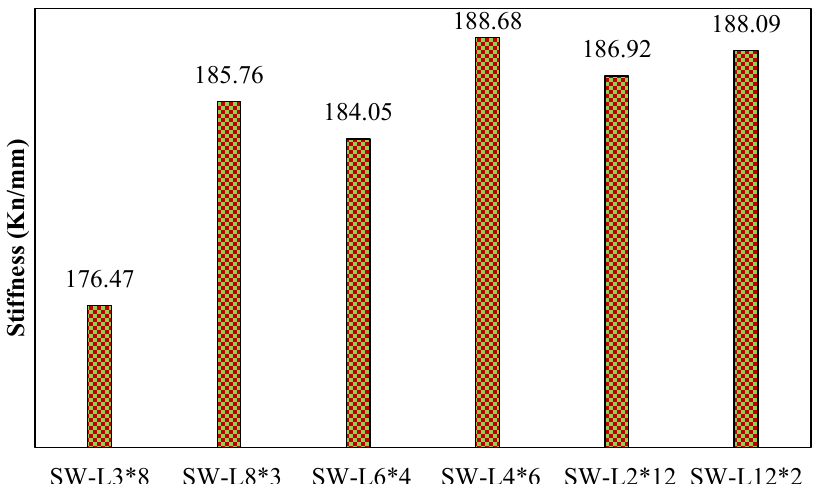
Figure 25. Stiffness of group 4.